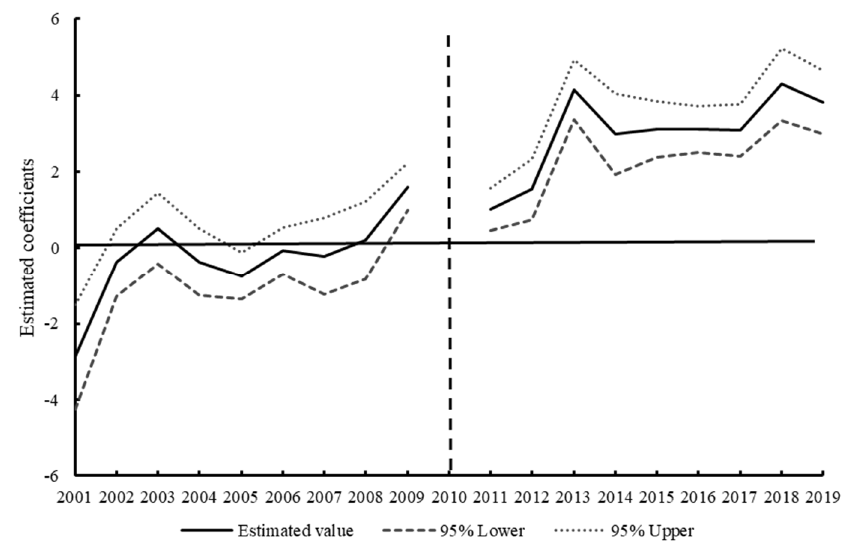
Figure 2. Dynamic effects of national key ecological function areas on CS.